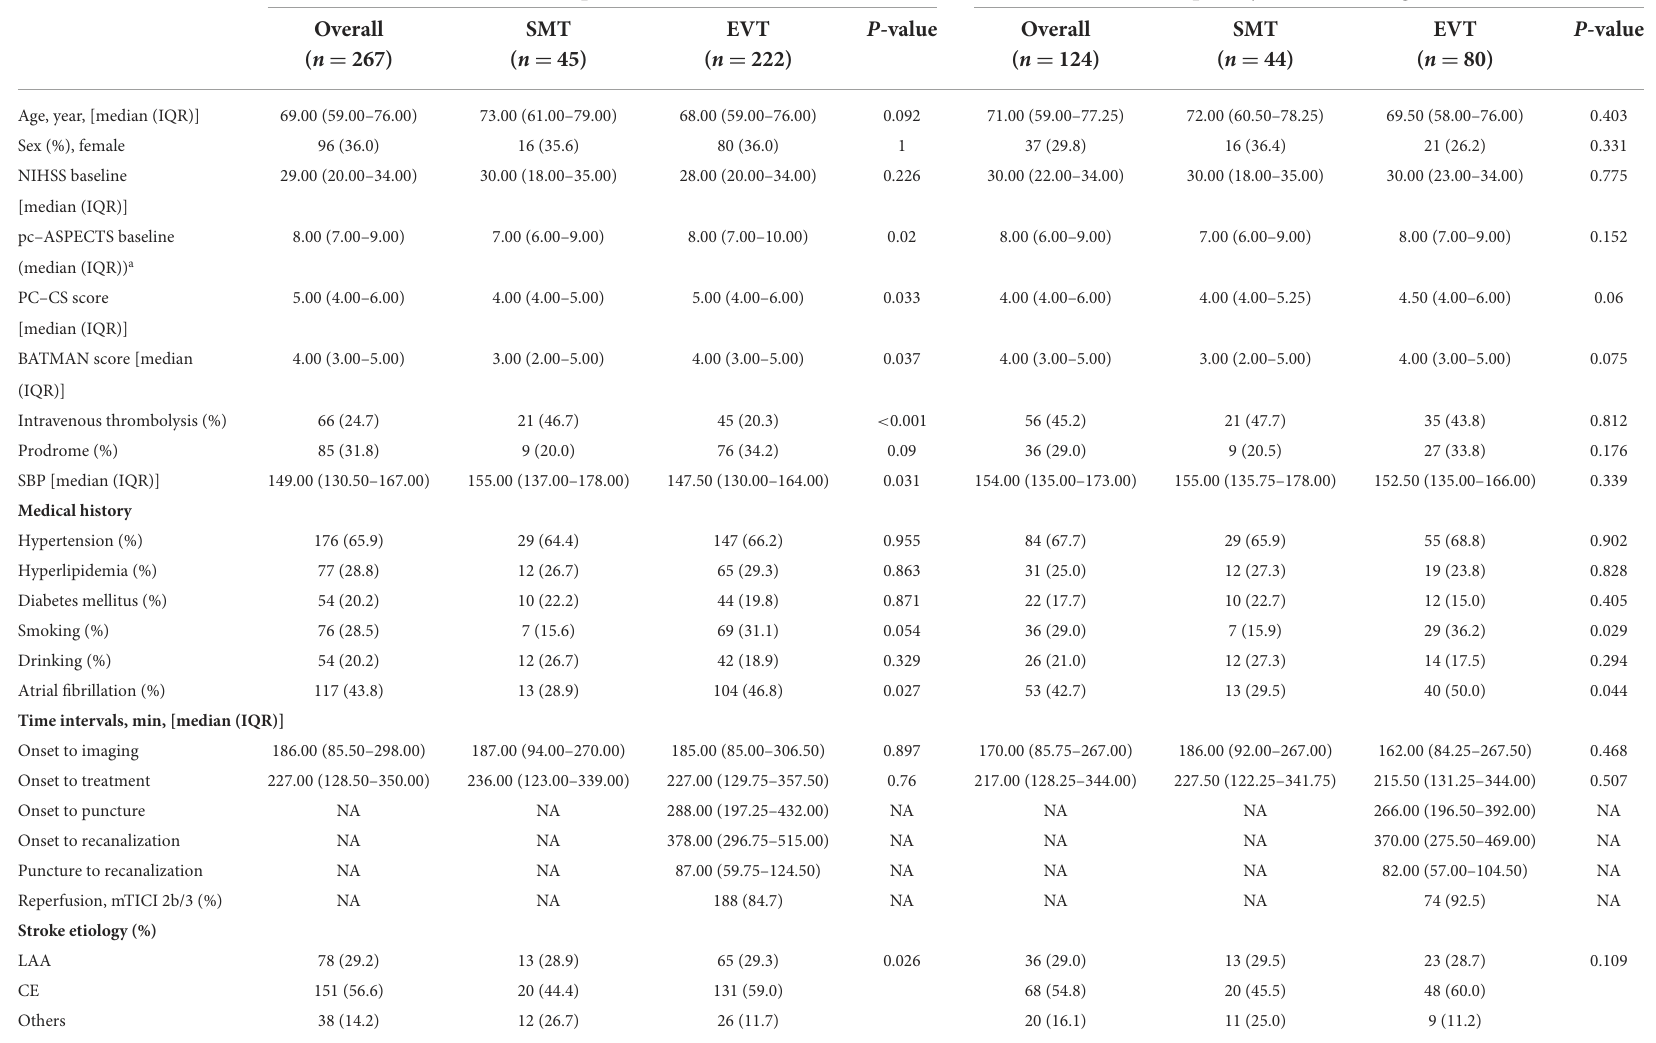
TABLE 1 Baseline